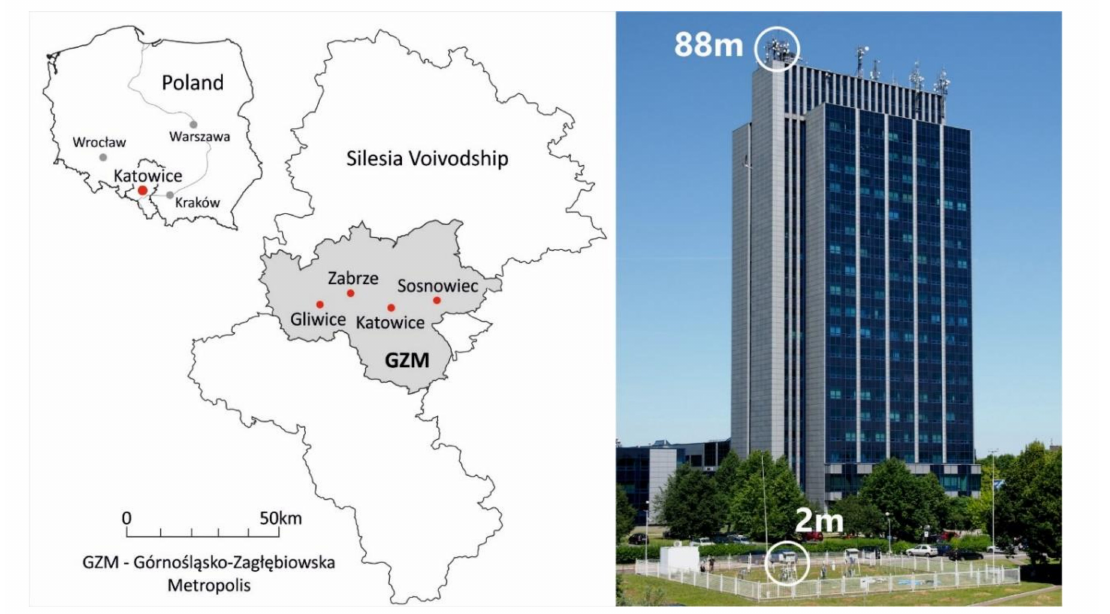
Figure 1. The research area (GZM), location of the gradient meteorological station with measurement points at 2 m and 88 m above ground level, and air monitoring